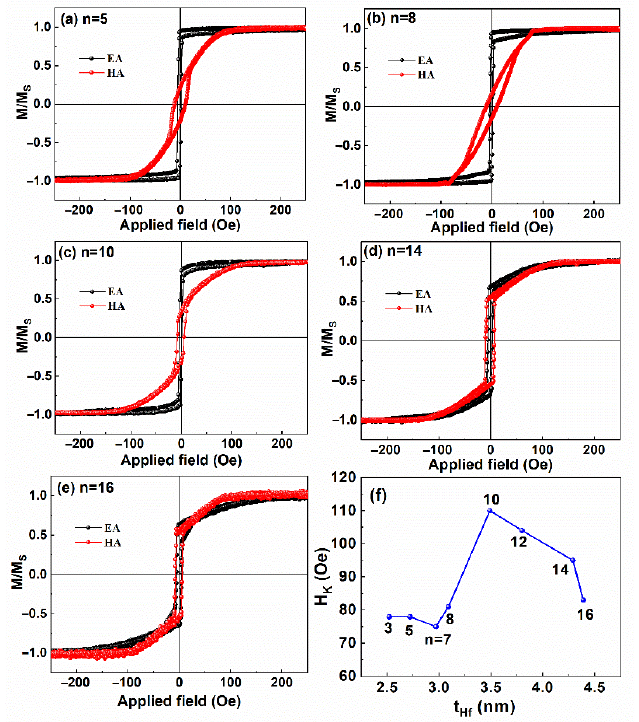
Figure 6. ( a – e ) The EA and HA hysteresis loops for trilayer segments at various positions; ( f ) the variation of anisotropy field H K with the hafnium thickness.